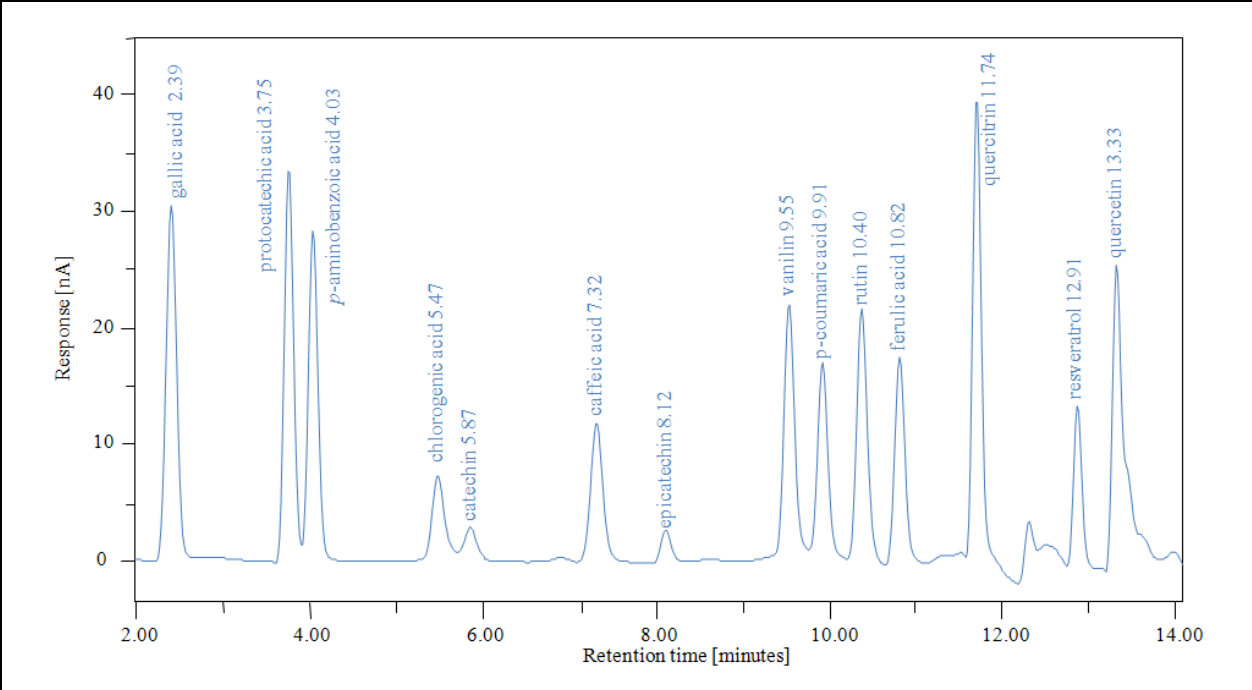
Figure 2. Chromatograms of mixture of standard phenolic compounds (retention times - gallic acid 2.39; protocatechuic acid 3.75; p -aminobenzoic acid 4.03; chlorogenic acid 5.47; catechin 5.87; caffeic acid 7.32; epicatechin 8.12; vanillin 9.55; p -coumaric acid 9.91; rutin 10.40; ferulic acid 10.82; quercitrin 11.74; resveratrol 12.91; quercetin